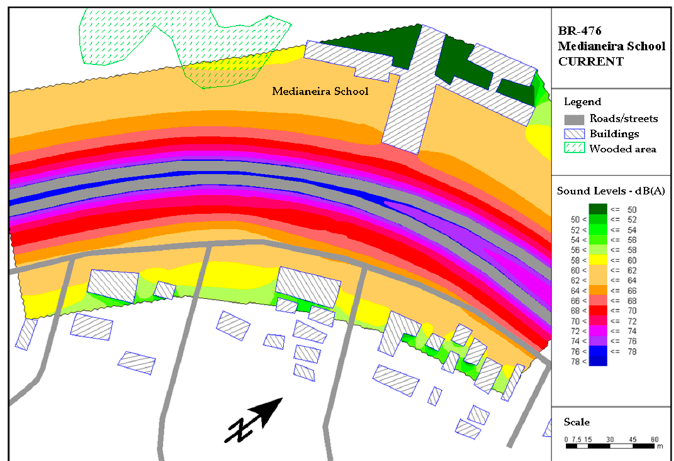
Figure 1. Noise map of highway BR-476 in the current situation: surroundings of Medianeira School.